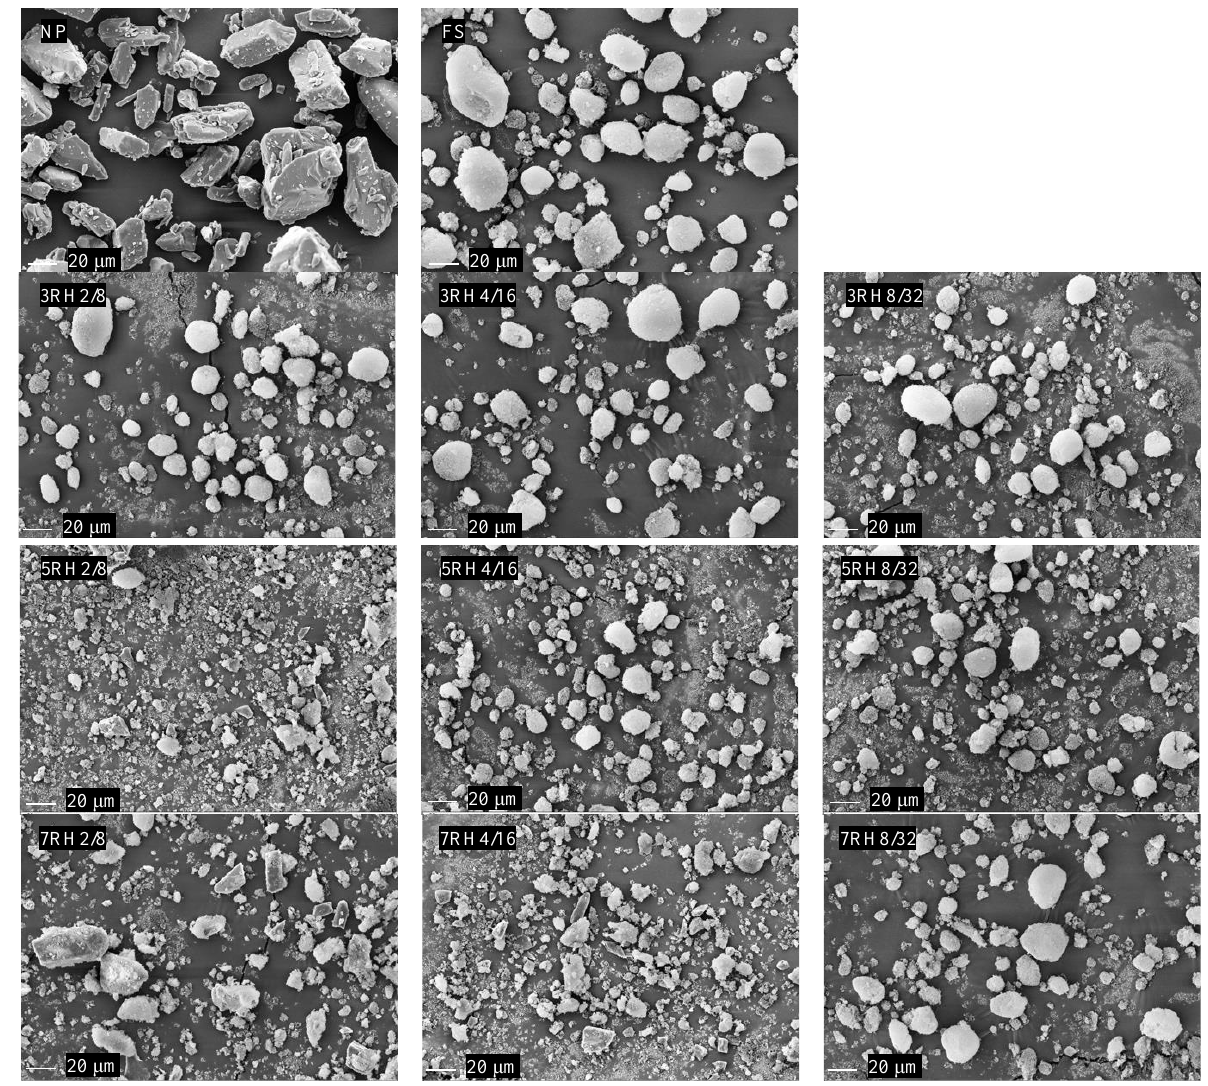
Figure 1. Scanning electron microscope (SEM) pictures of FS, NP, and dry medium internal-phase emulsions (dry